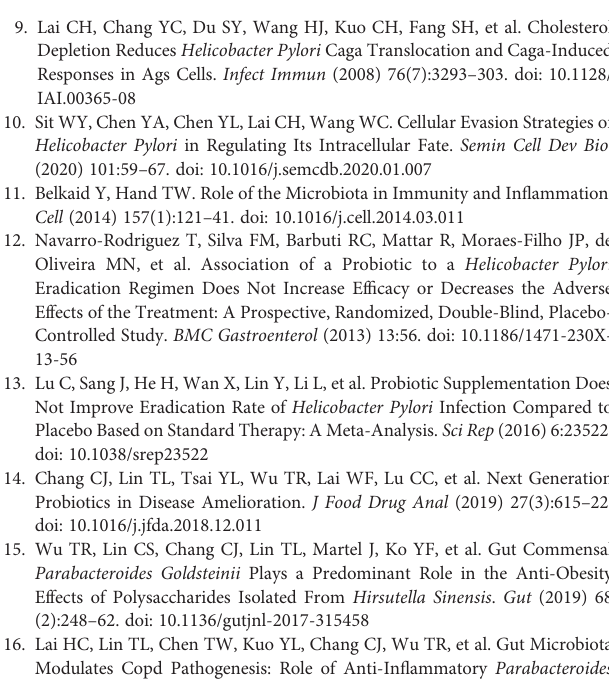
Supplementary Figure 1 | Body weight and temperature of mice during experimental studies.Mice were divided into four groups for the treatments with vehicle-control (PBS, n = 9), P. goldsteinii MTS01 (PG, n = 10), H. pylori (HP, n = 8), and P. goldsteinii MTS01 + H. pylori (n = 10). The body weight and temperature of the mice were recorded every week for a total of twelve weeks. Supplementary Figure 2 | Relative abundance of the gut microbiota in genera. The bacteria taxonomic pro fi les at genus level in the gut microbiota of the experimental mice. Relative abundance of (A) Lactobacillus, (B) Parabacteroides, (C) Lachnospiraceae_NK4A136_group, (D) Lachnoclostridium, (E) Ruminococcus_UCG014, (F) Ruminococcus_1, (G) Ruminiclostridium, (H) Ruminiclostridium_9, (I) Anaerosporobacter, (J) Candidatus_Arthromitus, (K) Turicibacter, (L) Anaeroplasma in the gut microbiota were analyzed. * P < 0.05. Supplementary Figure 3 | Differences in gut microbiota composition in mice administrated with P. goldsteinii MTS01 and H. pylori. LEfSe analysis exhibited the abundance bacterial species compared with (A) control and P. goldsteinii MTS01 + H. pylori ; (B) H. pylori and P. goldsteinii MTS01. Supplementary Figure 4 | Circular taxonomic and phylogenetic tree of gut microbiota diversity. Compared the effect of P. goldsteinii MTS01 and H. pylori altered microbiota composition in each group. Cladogram showed enriched taxa of gut microbiome in mice treated with (A) control and P. goldsteinii MTS01+ H. pylori ; (B) H. pylori and P. goldsteinii MTS01. Supplementary Figure 5 | Putative functions of microbiota community. The microbial functionality pro fi les altered by P. goldsteinii MTS01 and H. pylori were analyzed using PICRUSt2 to generate KEGG pathway. Functional features showed the comparison between (A) control and P. goldsteinii MTS01+ H. pylori ; (B) H. pylori and P. goldsteinii